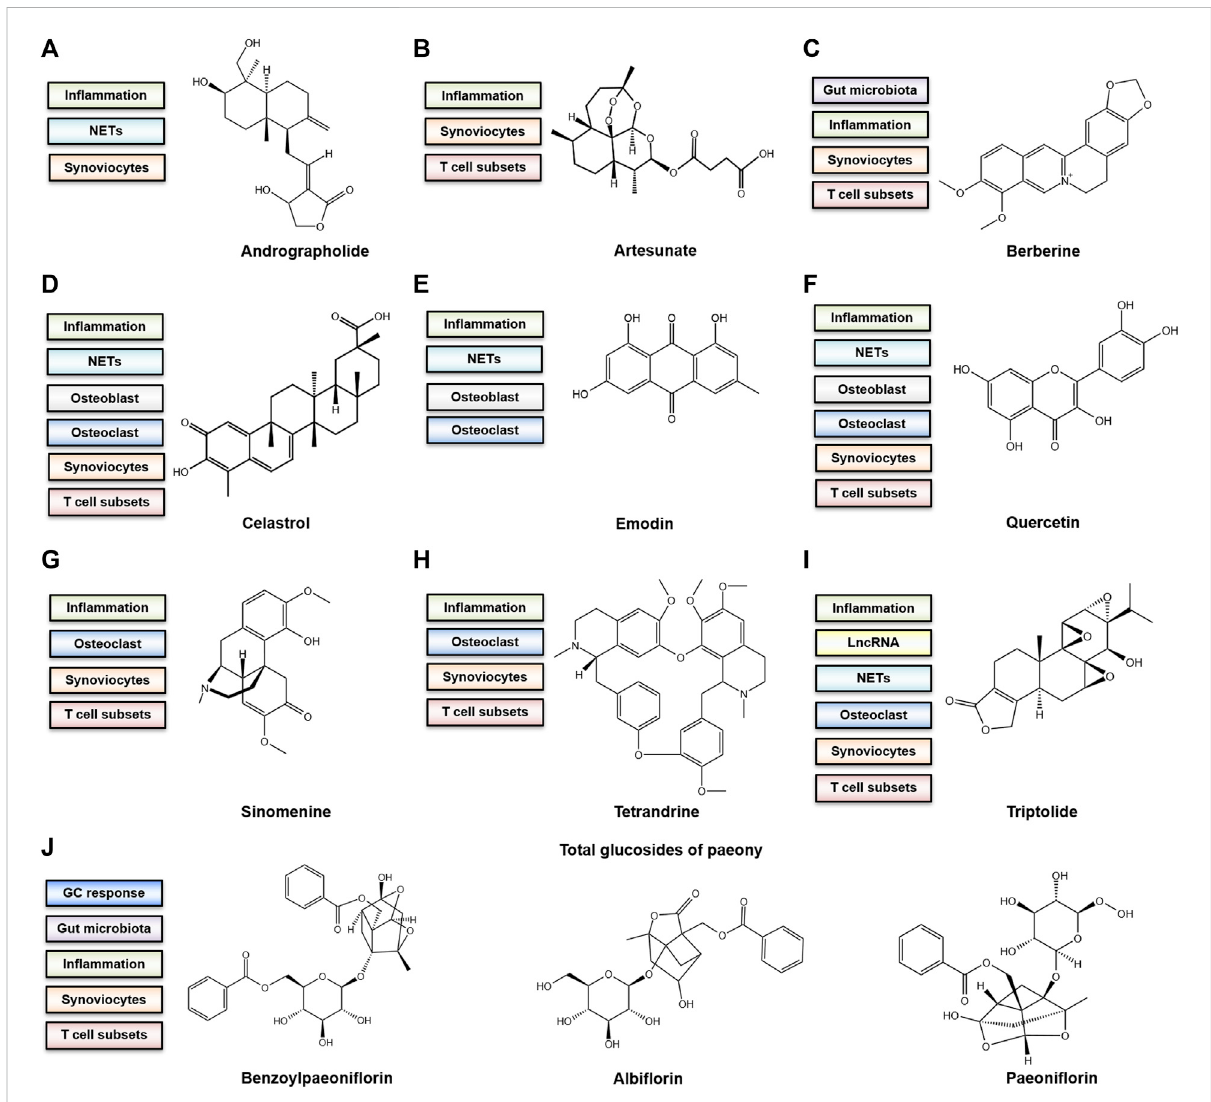
FIGURE 2 Thebone-protectivemechanism andchemical structure ofactive components (A) Andrographolide. (B) Artesunate (C) Berberine. (D) Celastrol (E) Emodin. (F) Quercetin (G) Sinomenine. (H) Tetrandrine (I) Triptolide. (J) Total glucosides of paeony (TGP). The chemical structure of representative ingredients from TGP are